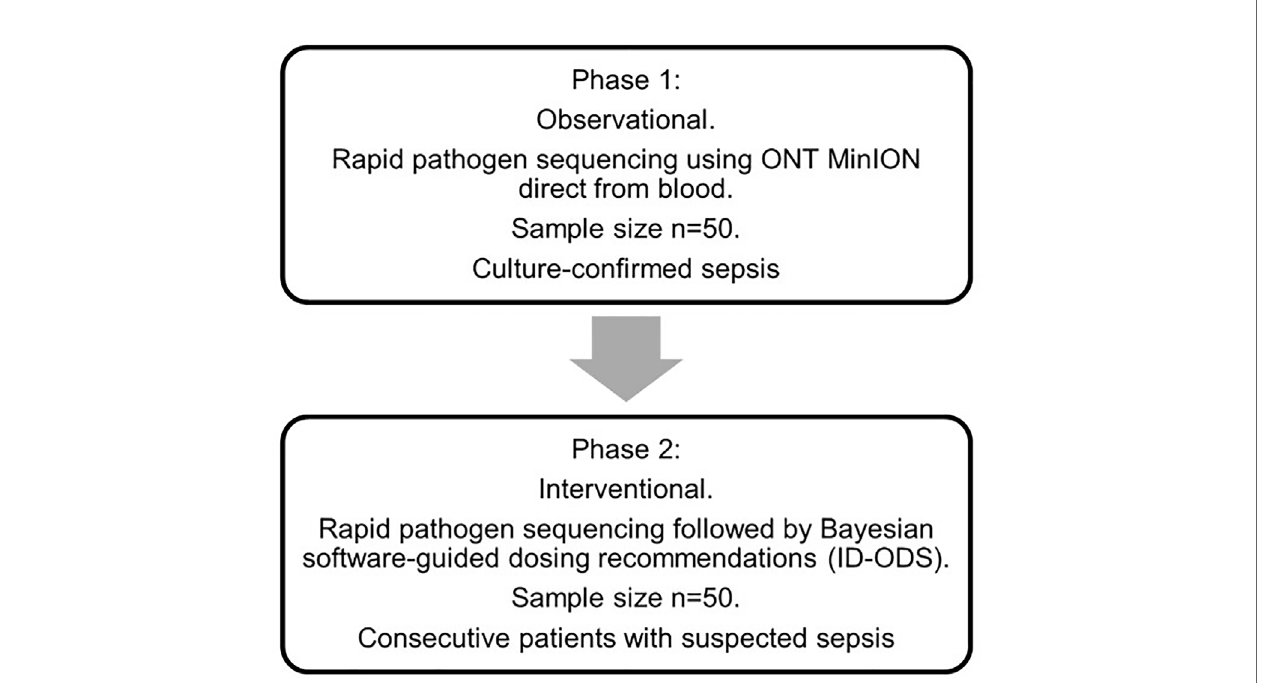
FIGURE 1 | Study fl ow diagram. Phase 1: In an initial observational phase of the study, participants will be recruited to a diagnostic accuracy study of MinION nanopore pathogen sequencing. The sample size for this phase of the study is 50 patients with blood culture-con fi rmed sepsis admitted to ICU. Phase 2: In Phase 2, consecutive patients with suspected sepsis admitted to ICU will undergo MinION nanopore pathogen sequencing integrated with personalised antibiotic therapy using a combination of Bayesian dosing software (ID-ODS ™ ) and measured antibiotic plasma concentrations. A senior ICU pharmacist/clinician at each site will lead this software-guided intervention of antimicrobial dose optimisation. All dosing regimens will be checked by both the senior ICU pharmacist and attending ICU consultant prior to prescription. The fi nal decision regarding the use of the optimised dosing of antibiotics will remain at the discretion of the attending ICU consultant. Software-guided dosing will continue until either: 1) the study antibiotic(s) have been ceased by the treating clinician, 2) the patient is discharged from ICU, 3) after 5 days of study antibiotic therapy. If antibiotic therapy is still required thereafter, dosing will be guided by the treating clinician. Adherence to dosing strategies informed by the dosing software will be supported by the use of senior ICU pharmacists trained in the use of this software-guided approach to antimicrobial dose optimisation. All dosing regimens will be checked by both the senior ICU pharmacist and attending ICU consultant prior to prescription, to ensure appropriateness and safety.